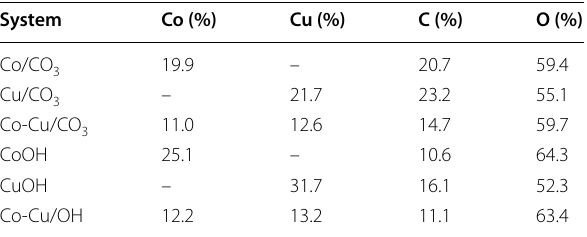
Table 2 EDS analysis (atomic %) of precipitates at pH